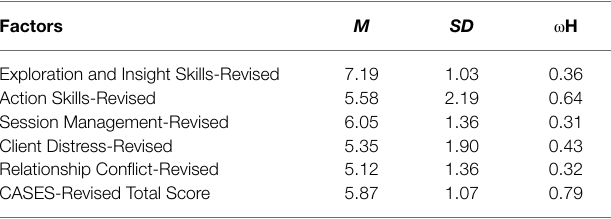
TABLE 4 | Correlations of the CASES-R total score and Action Skills-Revised (AS-R) subscale to related measures and therapists’ characteristics. Total sample ( N = 670)